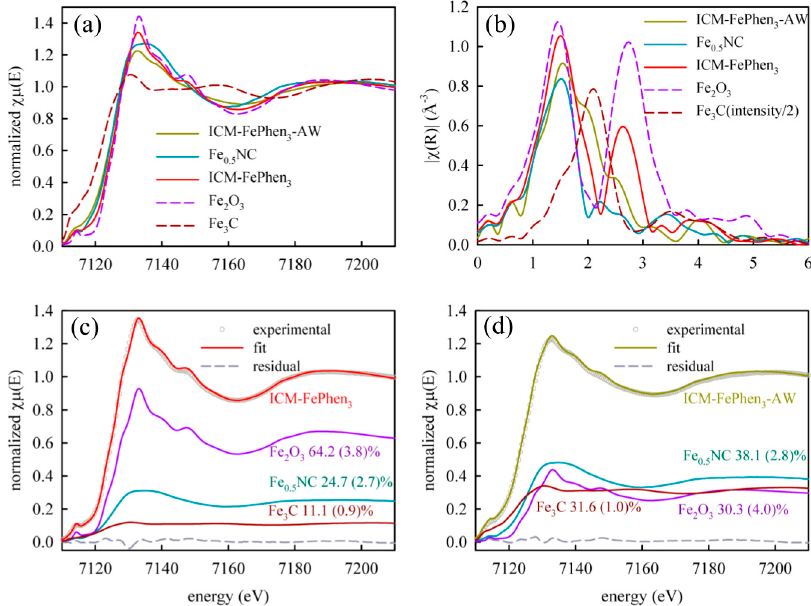
Figure 4. X-ray absorption spectroscopy characterization of ICM-FePhen 3 and ICM-FePhen 3 -AW. ( a ) Fe k-edge X-ray absorption near edge structure (XANES) spectra, ( b ) Fourier transforms of the extended X-ray absorption fine structure (EXAFS) spectra. The spectra of Fe 2 O 3 , Fe 3 C and Fe 0.5 NC (an Fe-N-C material comprising exclusively atomically dispersed FeN x moieties [11]) are also shown. Linear combination fitting (LCF) of the Fe k-edge XANES spectra of ( c ) ICM-FePhen 3 and ( d ) ICM-FePhen 3 -AW with Fe 2 O 3 , Fe 3 C and Fe 0.5 NC as references. Error bars are given in parentheses.